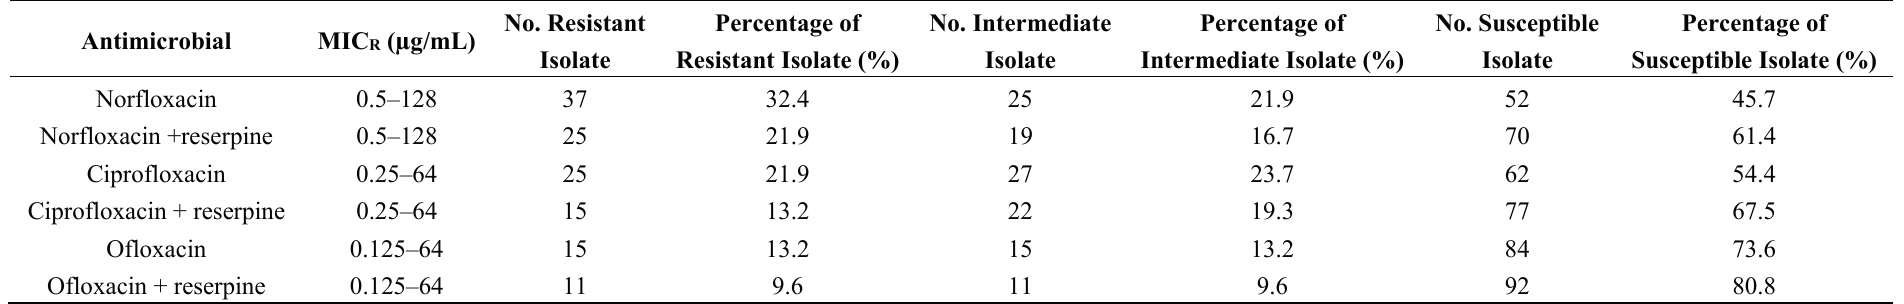
Percentage of Resistant Isolate (%) 21.9